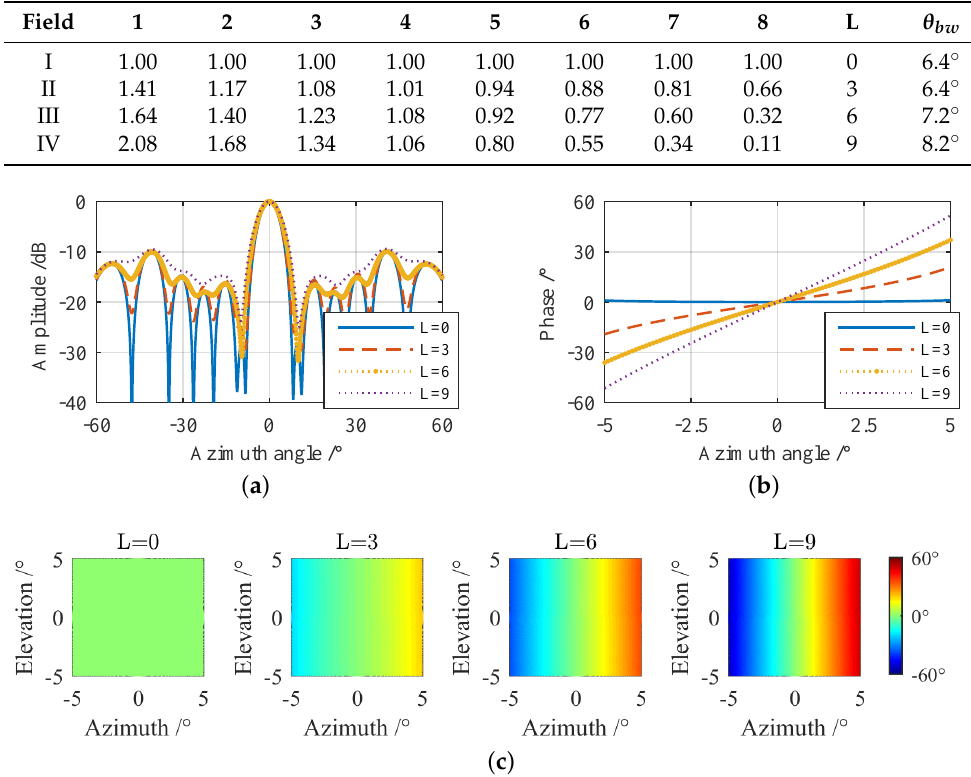
Table 1. Relative amplitude coefficients of eight units.